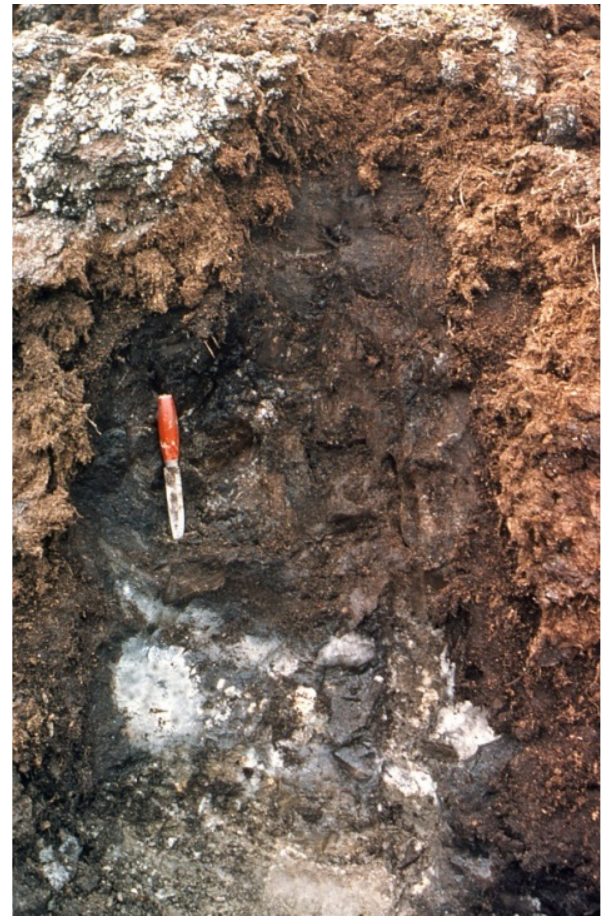
Figure 3. Example of perennially frozen organic soil (Histel) de- veloped on moss peat with a high ice content (white areas) in the subsoil. Photograph by C. Tarnocai, previously published in Jones et al. (2010) and Tarnocai and Bockheim